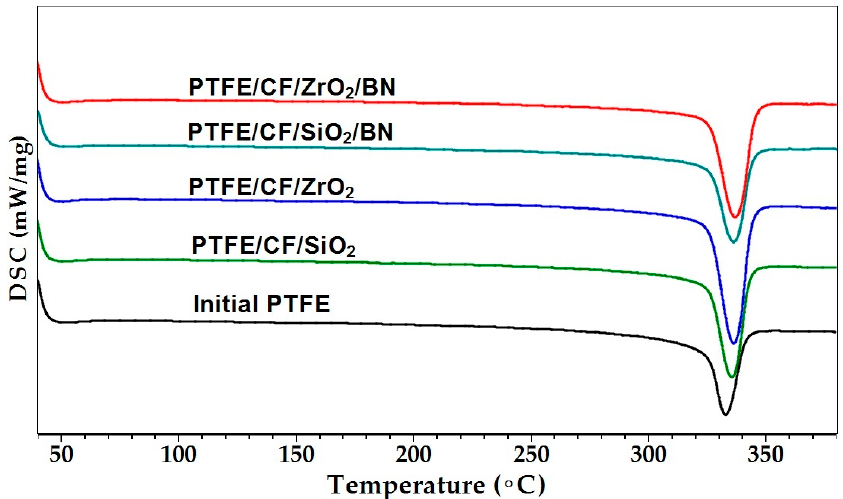
Figure 5. DSC thermographs of the initial PTFE and PCM.